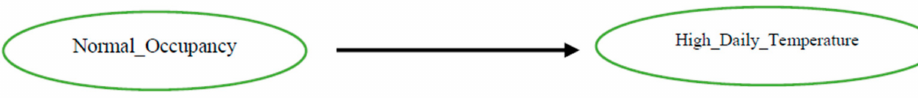
Figure 16. An example causal relation in FBBN based on the